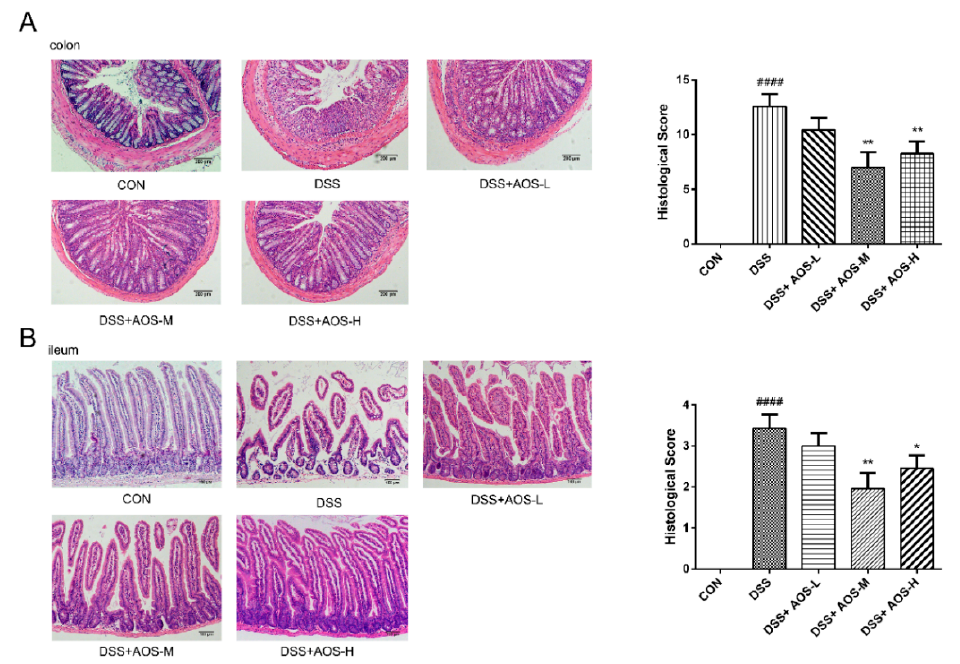
Figure 3. Effects of AOS on histological changes in colonic and ileal tissues. ( A ) Histopathological images and scores of colonic tissues; scale bar = 200 µ m. ( B ) Histopathological images and scores of ileal tissues; scale bar = 100 µ m. * p < 0.05, ** p < 0.01 vs. DSS group; #### p < 0.0001 vs. Control group; n = 3.